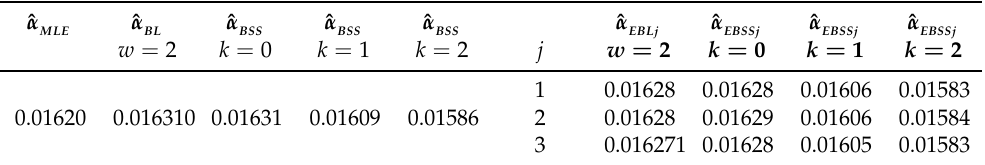
Table 15. Estimations of α , with s = 10, β = 1.4142, u = 3, v =